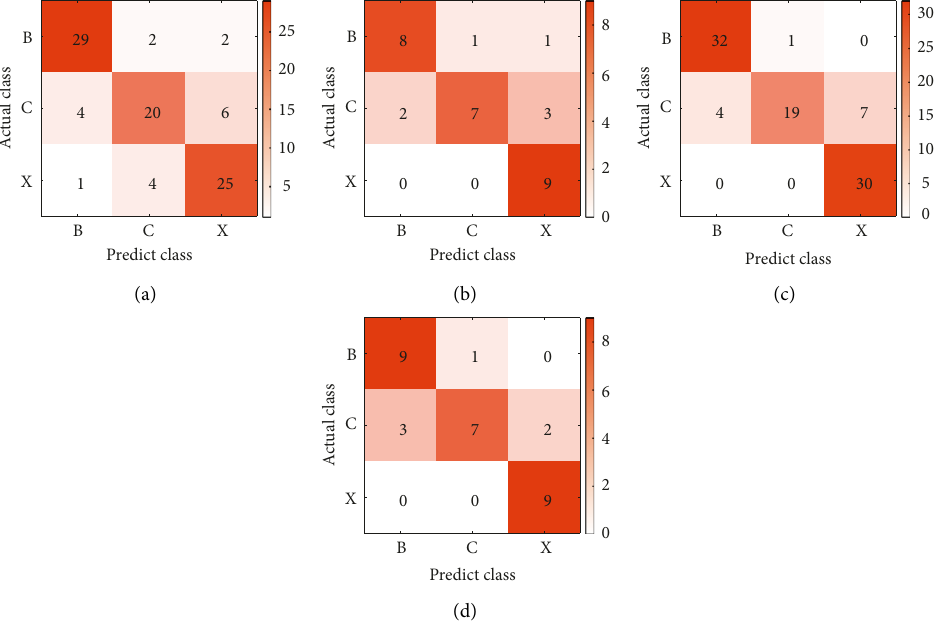
Figure 4: Confusion matrix description results of PLS-DA model and NSGA-II-PLS-DA model in the modeling and prediction process: (a) Calibration and (b) Prediction of PLS-DA model. (c) Calibration and (d) Prediction of NSGA-II-PLS-DA